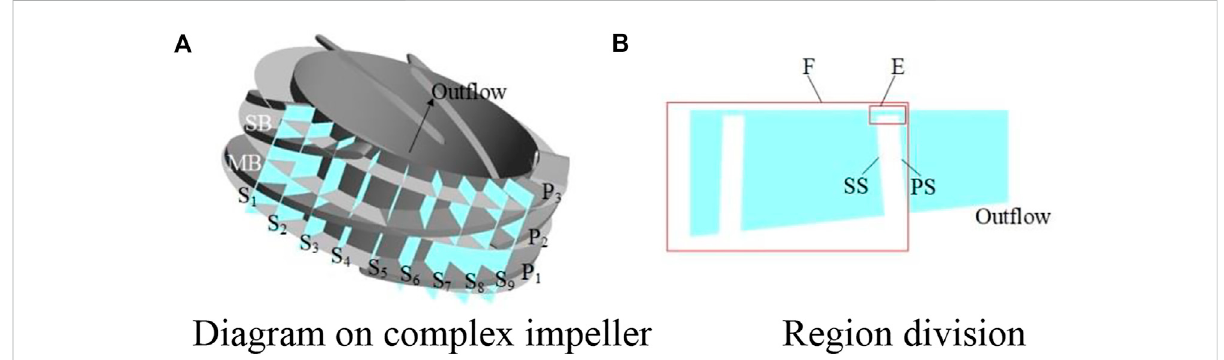
FIGURE 6 Diagram of the section and axial surface. (A) Diagram of the complex impeller. (B) Region division.